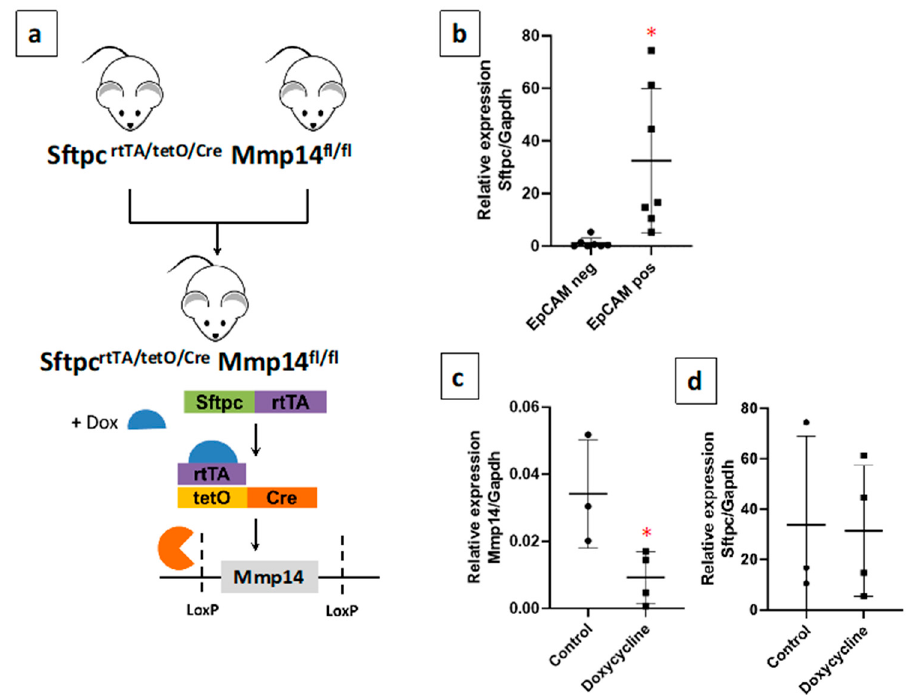
Figure 2. Mmp14 deletion in type 2 alveolar epithelial cells. ( a) Schematic diagram demonstrating cell-specific Mmp14 deletion. Doxycycline-inducible Sftpc rtTA/TetO/Cre mice were crossed with Mmp14 fl/fl mice. ( b) Sftpc expression in isolated cells and selected by EpCAM microbeads. (c,d) Mmp14 and Sftpc expression in the positive EpCAM fraction from conditional KO mouse